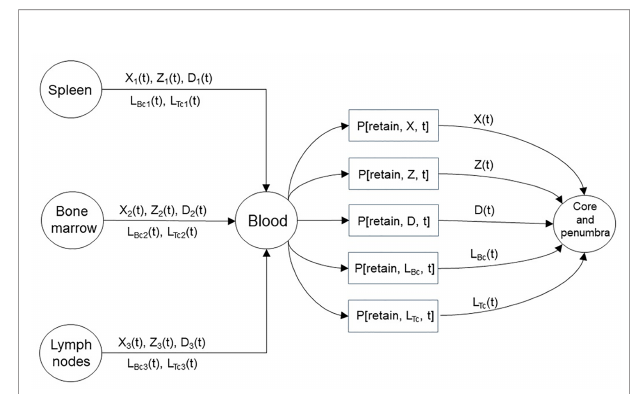
FIGURE 3 | A representation of the immune organs that provide the macrophages, neutrophils, dendritic cells, and lymphocytes that in fi ltrate the core and penumbra following stroke. The immune organs shown represent three distinct sources with the brain being the destination. The amount of immune cells traversing from the spleen, bone marrow, and lymph nodes are written above and below the medium connecting the source-destination pairs. The cellular travel illustrated above occurs as a consequence of a chemokine gradient. The presented model introduces the as time-varying quantities that contribute to the formation of the infarct by regulating the retention of the emitted immune cells by the three sources through the